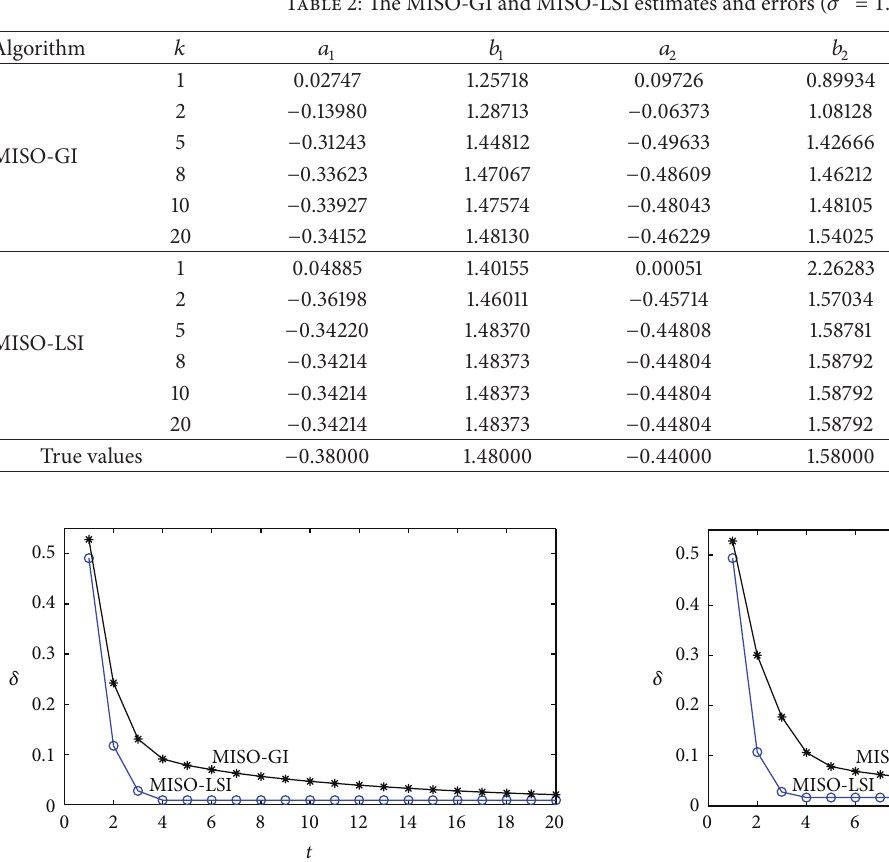
Figure 2: The parameter estimation errors 𝛿 versus 𝑡 ( 𝜎 2 = 0.50 2 ). Figure 3: The parameter estimation errors 𝛿 versus 𝑡 ( 𝜎 2 = 1.00 2